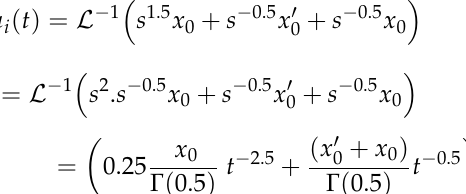
Figure 27. Control Architecture for Techniques 1–4 with Arbitrary Initial Conditions.